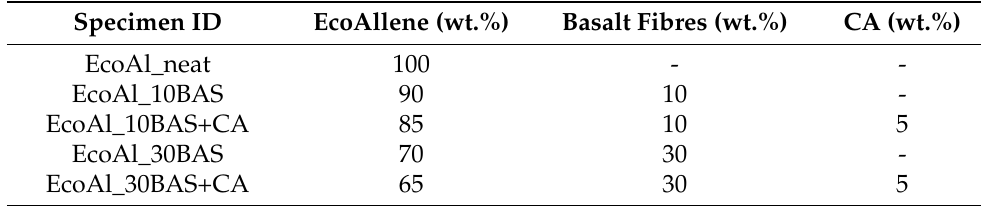
Table 1. List of all EcoAllene-based